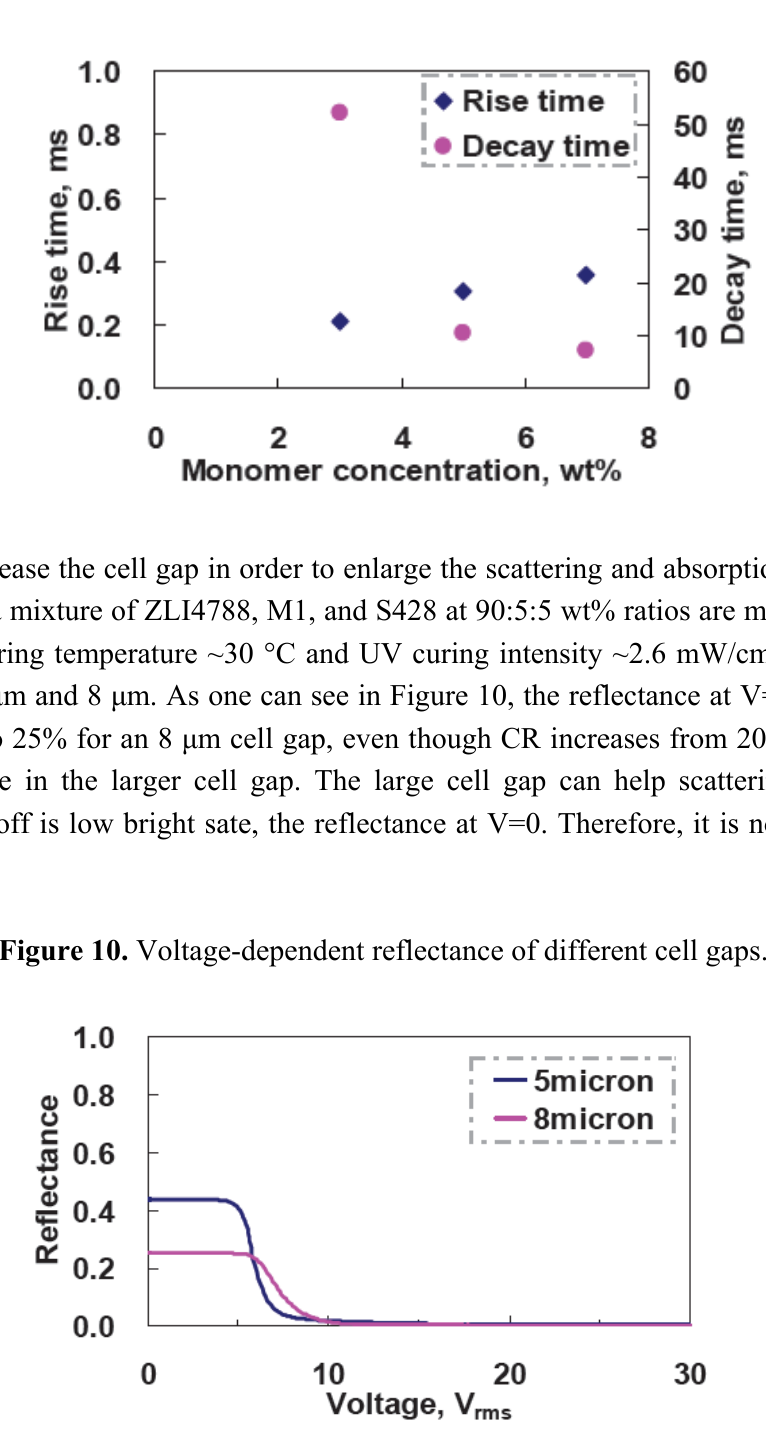
Figure 9. Measured response time as a function of monomer concentration.